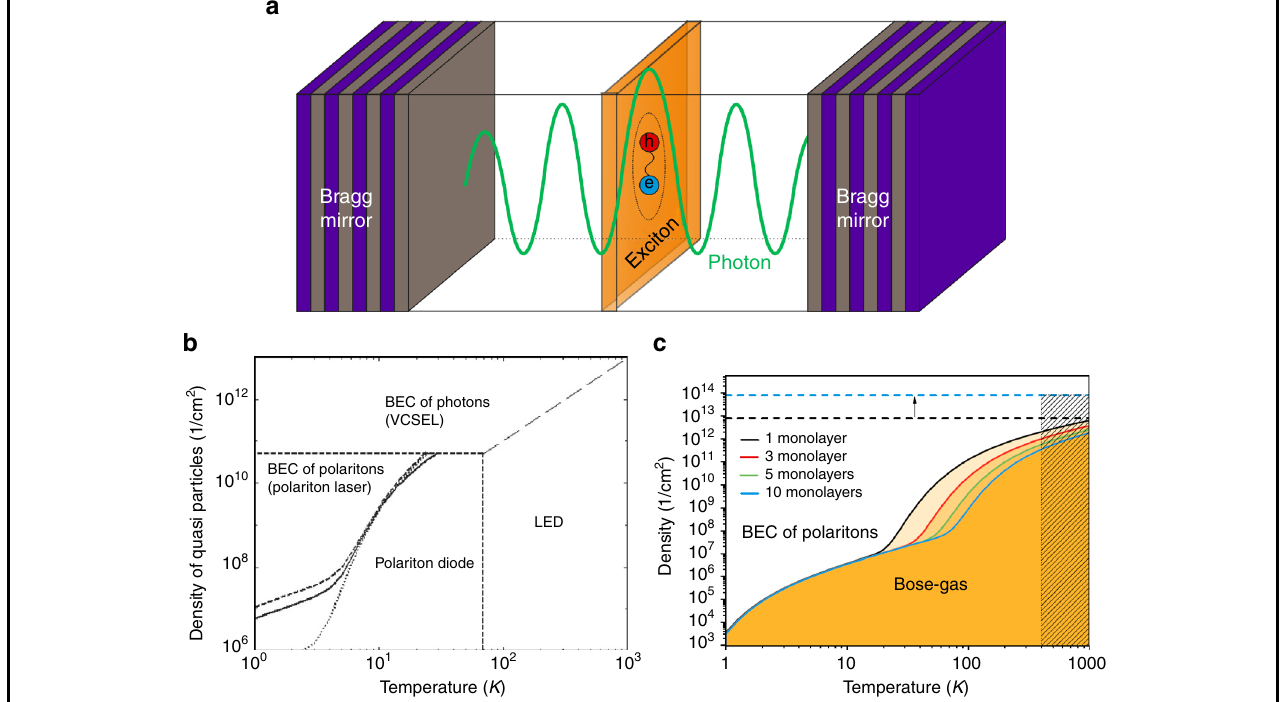
Fig. 1 . ( a ) schematics of a microcavity with embedded active media supporting excitons. ( b ) phase diagrams of equilibrium exciton-polaritons in conventional GaAs-based structure from Ref. [21], adapted from Kavokin et al, 2003. c 2003 Materials Research Society ( c ) phase diagrams of equilibrium exciton-polaritons in the structure containing TMDC monolayers from Ref. [22] . BEC is Bose-Einstein condensate. reproduced from Lundt, N et al, Monolayered MoSe2: a candidate for room temperature polaritonics, 2D Materials Volume 4, Number 1, 2016. Published under a Creative Commons CC BY 3.0